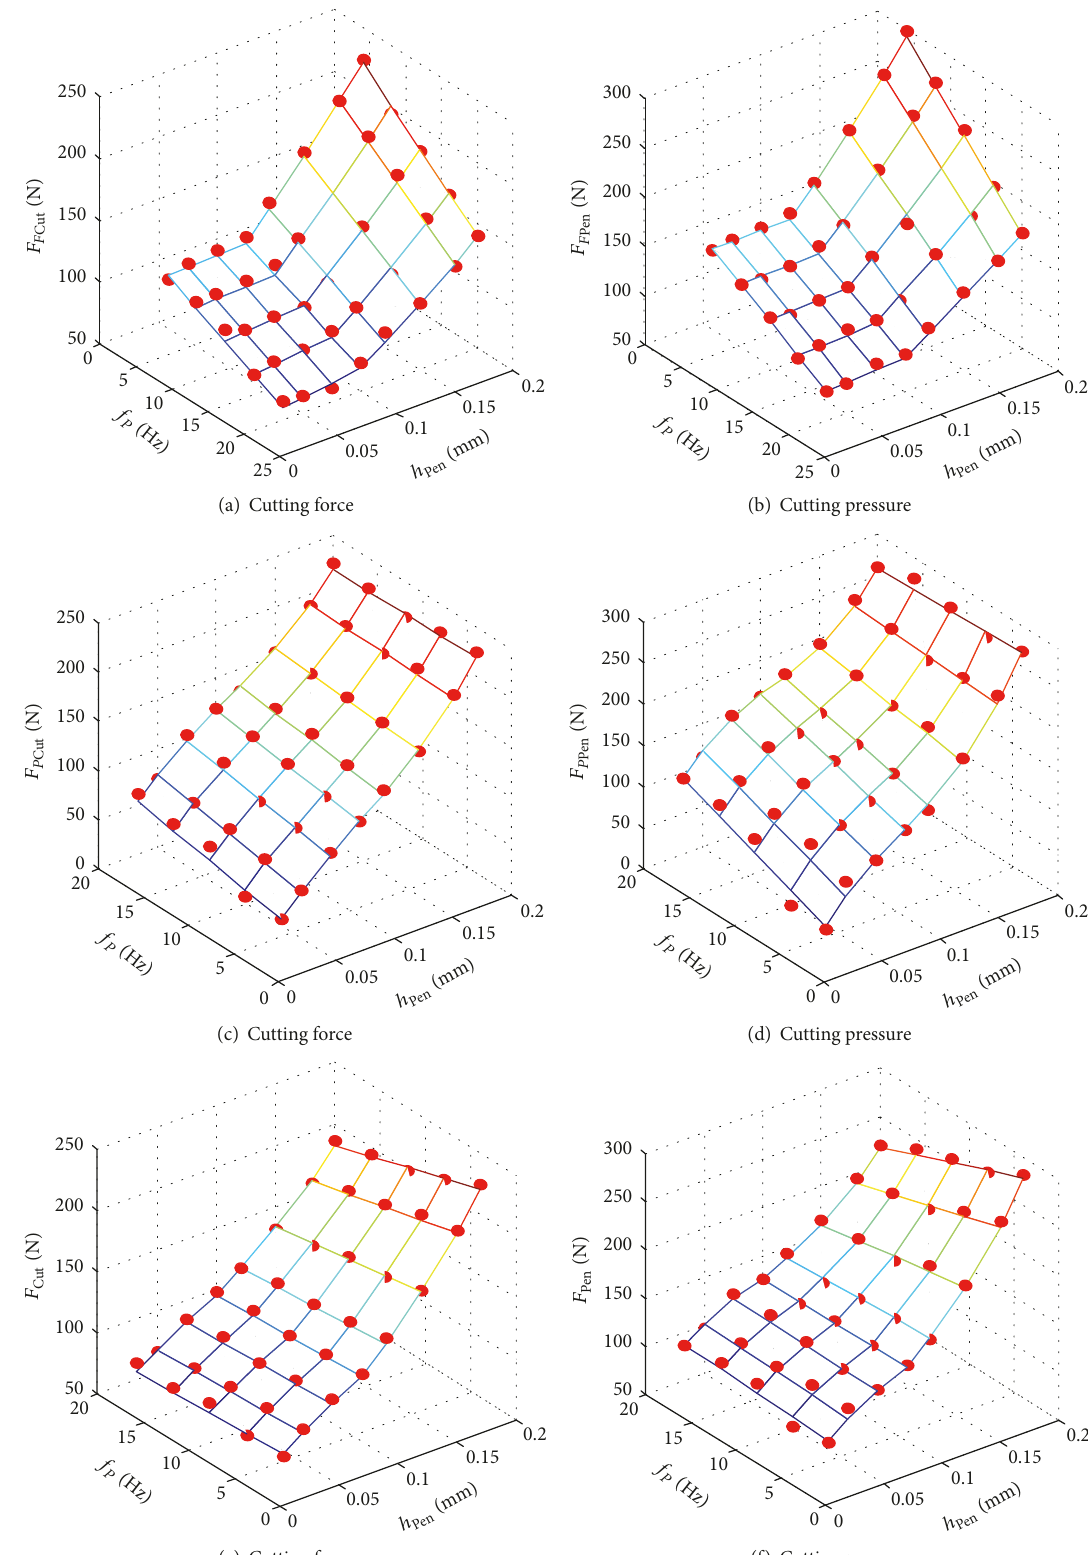
Figure 11: Trends of the average impact-cutting load on the lunar rock simulant versus the percussion frequency and the cut